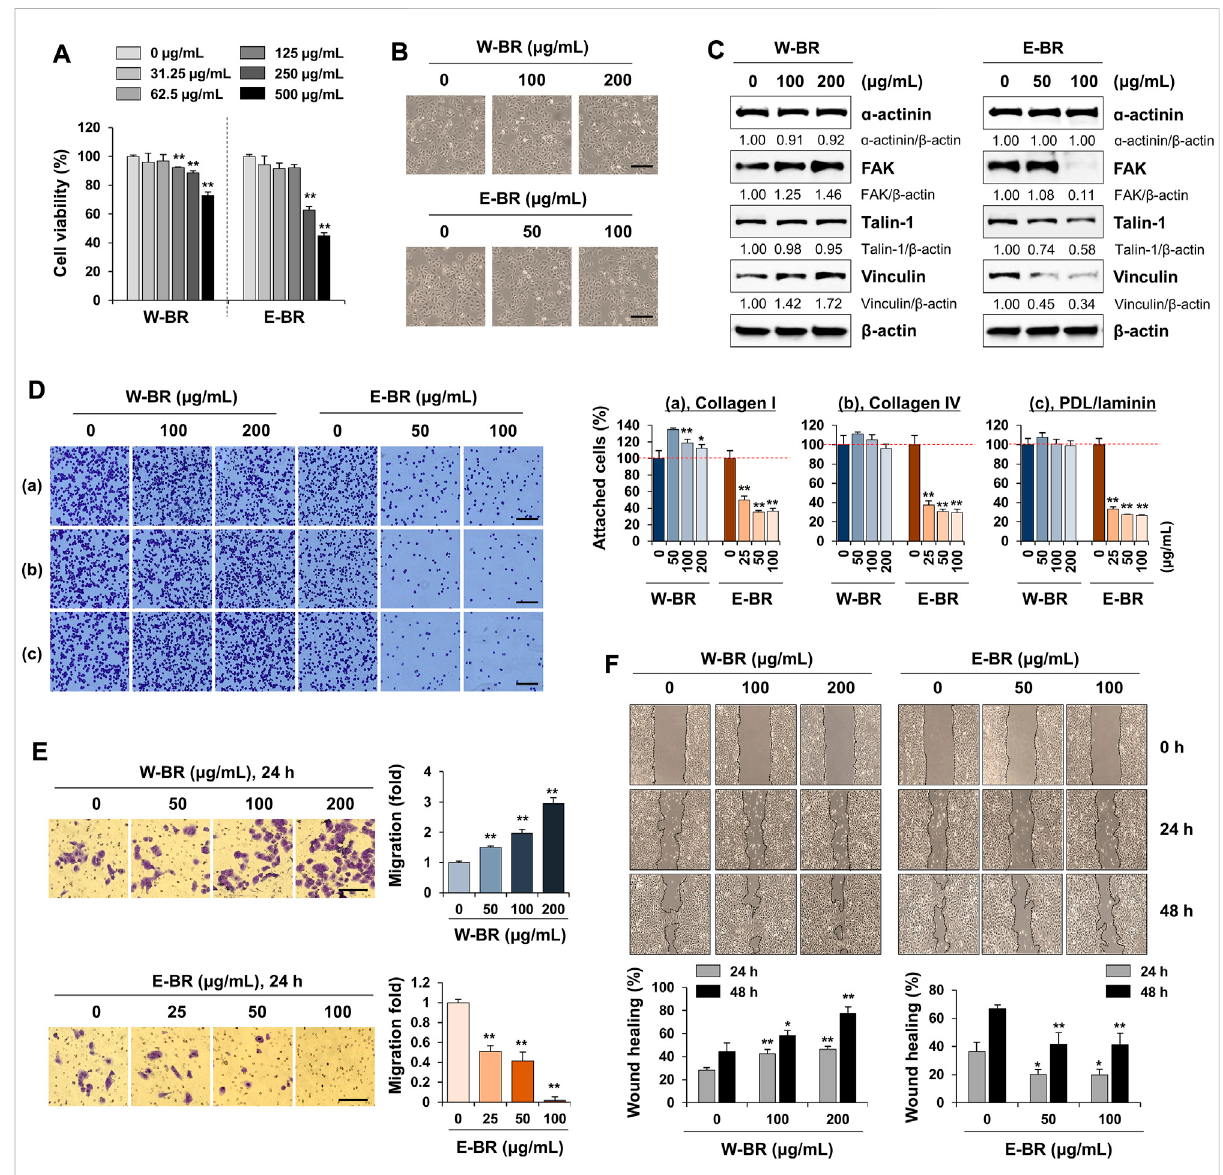
FIGURE 3 Effects of bupleuri radix water extract (W-BR) and bupleuri radix ethanol extract (E-BR) on proliferation, adhesion, and migration of A549 cells. (A) A549 cells were treated with W-BR or E-BR for 24 h, and viable cells were counted using the EZ-Cytox reagent. Relative cell viability compared with vehicle-treated cells is expressed as means ± SD. (B) A549 cells seeded on 24-well culture plates were treated with W-BR and E-BR for 24 h. Cells were photographed under an inverted microscope. Scale bar = 100 μ m. Original magni fi cation × 100. (C) Expression of focal adhesion- relatedproteinswasdeterminedusingimmunoblotting inW-BR-andE-BR-treatedA549 cells. β -Actinwasusedas loadingcontrol.After measuring protein band intensities using the ImageJ software, relative values compared with those for vehicle-treated control cells were calculated upon normalization to β -actin expression. Data are representative of two independent experiments. (D) A549 cells pretreated with or without W-BR and E-BR for 24 h were seeded onto collagen I, collagen IV, or poly-D-Lysine/laminin-coated wells and incubated for 30 min. After washing, attached cellswerecounted.Scalebar=100 μ m.Originalmagni fi cation×100. (E) A549cellspretreatedwithorwithoutW-BRandE-BRfor24 hwereloaded on the upper side of the transwell chamber. After fi lling the lower side with 10% fetal bovine serum/RPMI, the cells were further incubated for 24 h. Migrated cells were stained using a crystal violet solution and then observed under a phase-contrast inverted microscope. Scale bar = 200 μ m. Originalmagni fi cation×100. (F) A549cellsgrown upto90%con fl uenceweretreatedwithmitomycinCfor30min,andtheninjurylinesweremade. After being washed, the cells were incubated in 10% fetal bovine serum/RPMI containing 100 and 200 μ g/mL W-BR or E-BR for 48 h. Cell migration